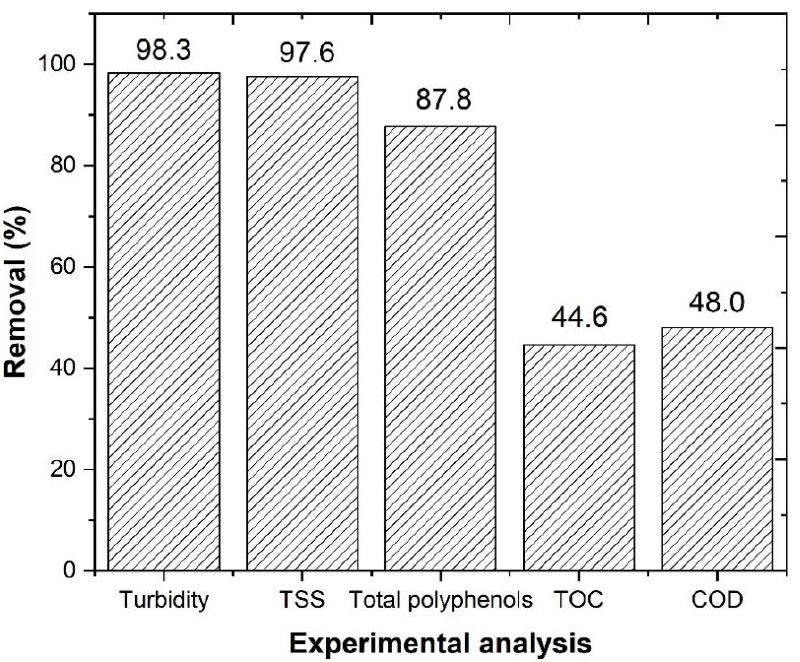
Figure 5. Overall results after coagulation–flocculation–decantation process (CFD). Operational conditions: 0.48 g/L potassium caseinate, 0.52 g/L bentonite, pH 4.0, temperature 298 K, rapid mix 150 rpm/3 min, slow mix 20 rpm/20 min an 12 h of sedimentation time.